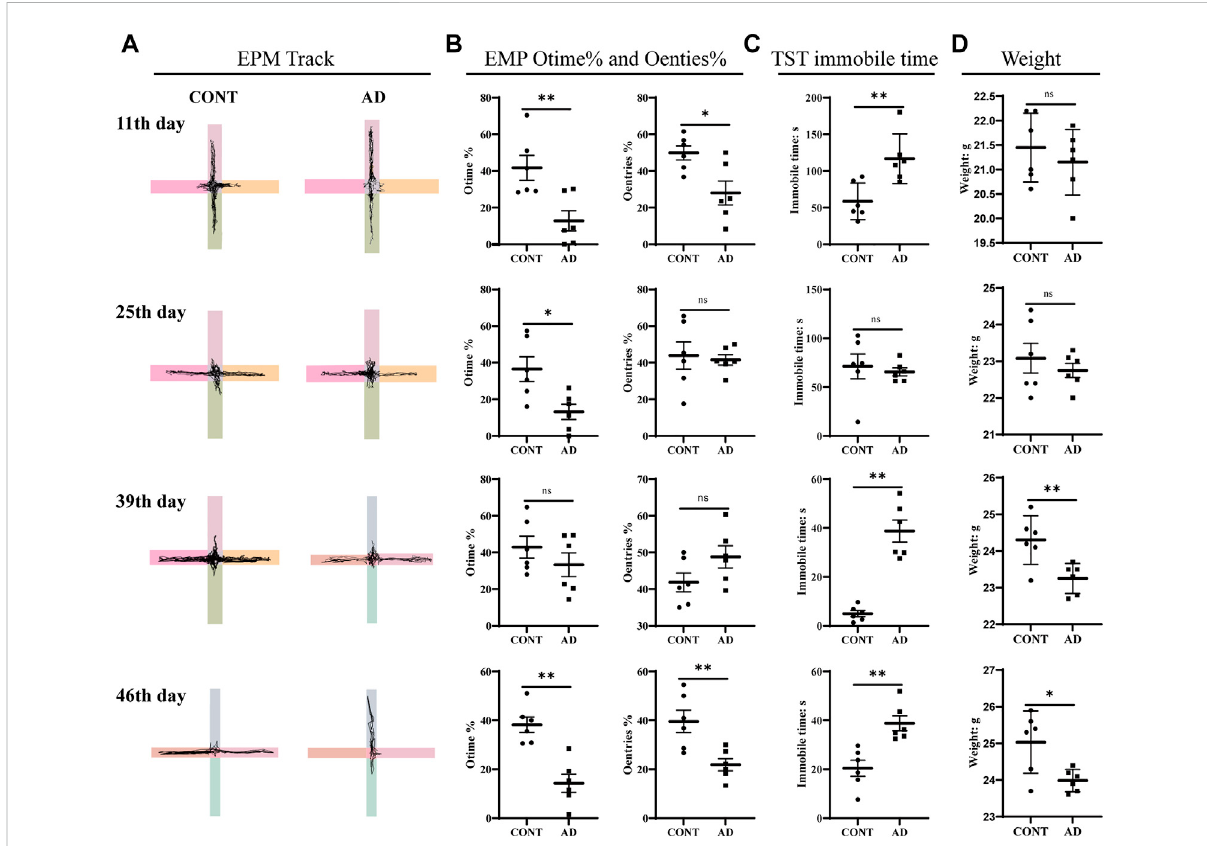
FIGURE 2 EMP, TST, and weights. (A) EPM track, the horizontal axis is the open arm and the vertical axis is the closed arm. (B) Results of EMP Otime% and Oentries%. (C) TST immobile time. (D) Weights: all data are presented as mean ± SD; n = 6 mice/group. * p < 0.05, ** p < 0.01 vs . the CONT group. CONT, normal mice; AD, DNFB-treated